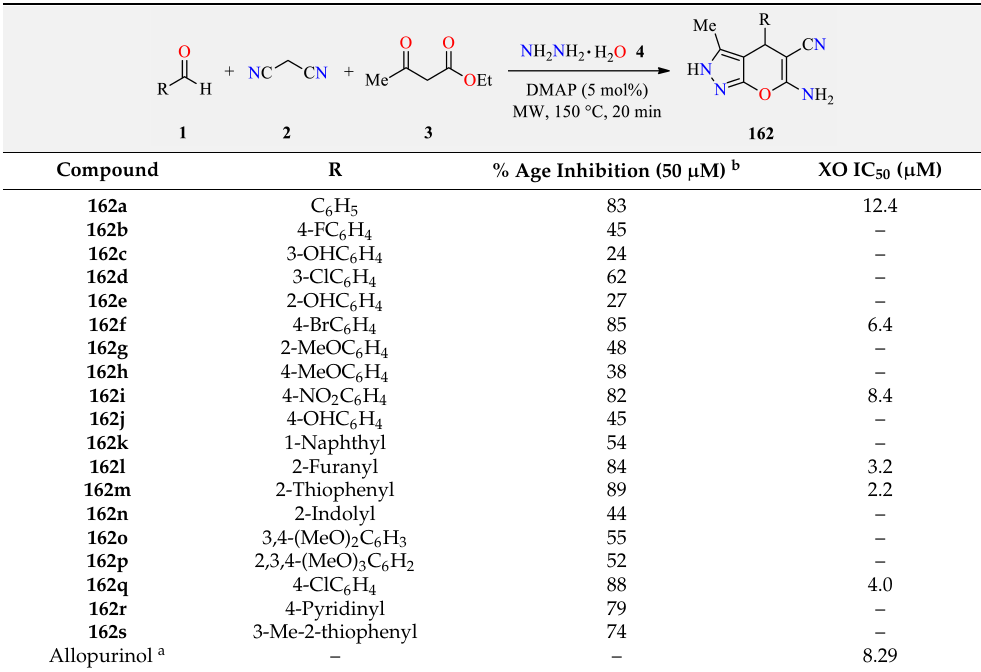
Table 53. Microwave-assisted four-component synthesis of pyrano[2,3- c ]pyrazoles 162 as non-purine xanthine oxidase